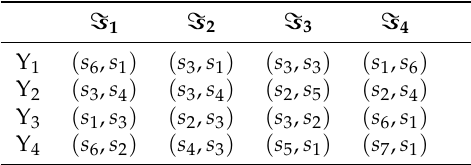
Table 6. Decision matrix R 1 by expert Z 1 .